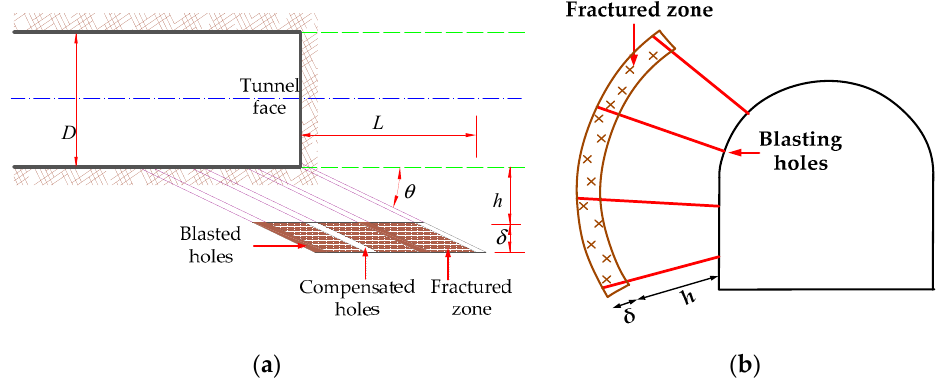
Figure 10. The diagram of advanced oblique holes and fractured zone: ( a ) Top view and ( b ) elevation